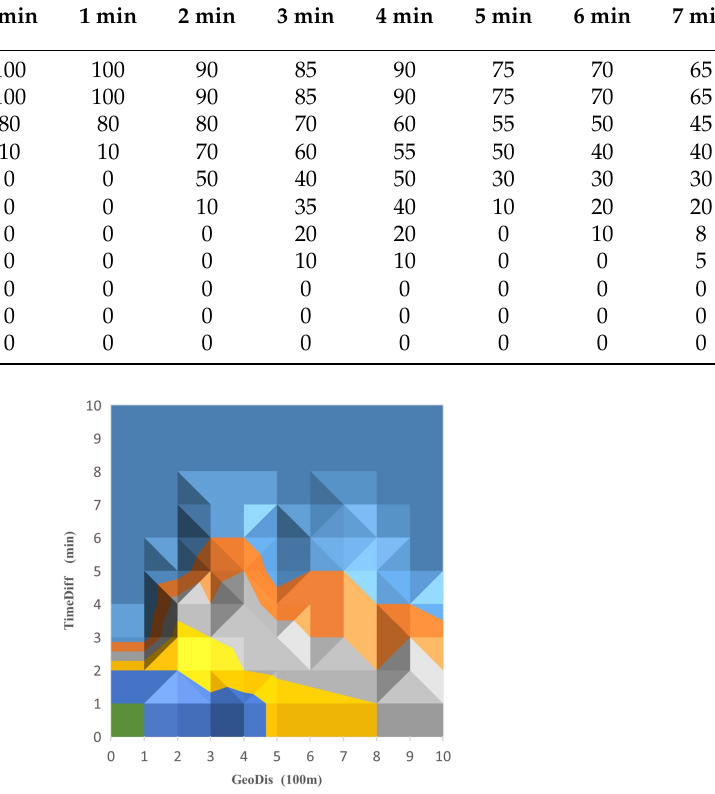
Figure 5. Visualization of affinity score of face–phone trajectory point